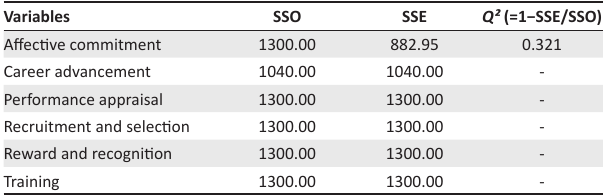
TABLE 4: Q 2 – indicator of cross-validated